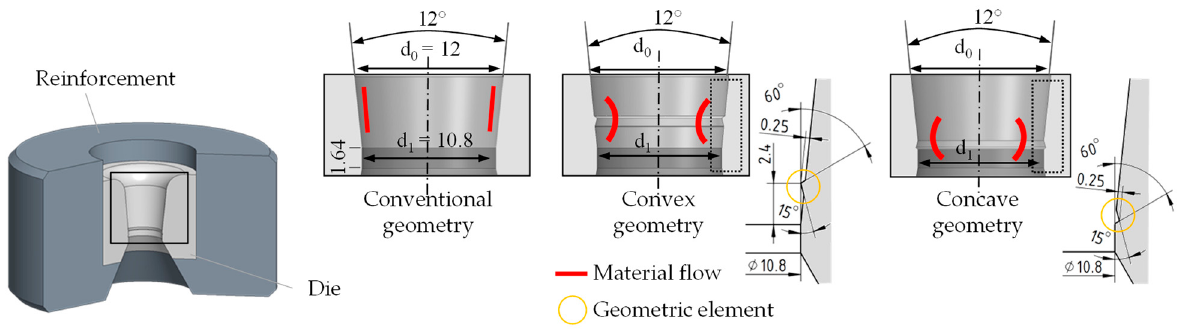
Figure 6. Geometry variants with special geometric elements.